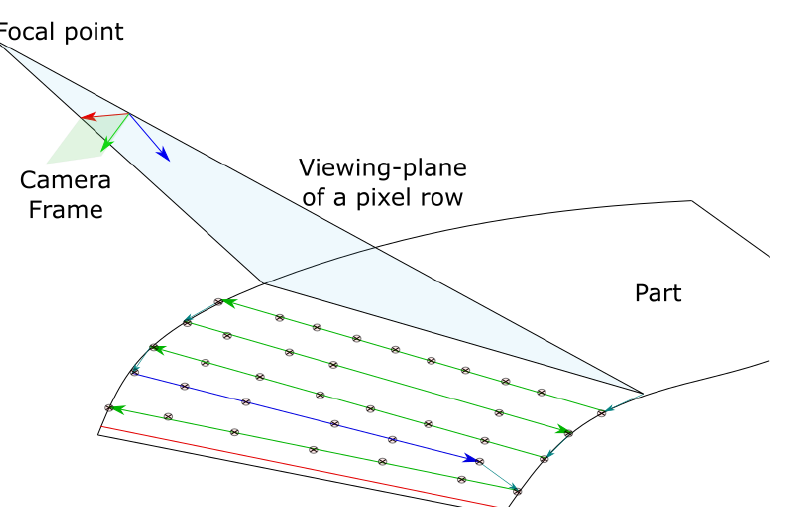
Figure 3. The viewing frustum of a camera intersects with the part along planes given by either each row or column of pixels. The planes of this chosen direction return points along the surface that form a raster-segments. These ordered raster segments can be reduced (red) if too close together, or regionally padded (blue) if the smallest distance from one raster-segment to another is larger than the sensor aperture. Key points (dots) can then be extracted directly from the point cloud and used as way-points. The overall path combining original (green) and inferred raster lines (blue) are